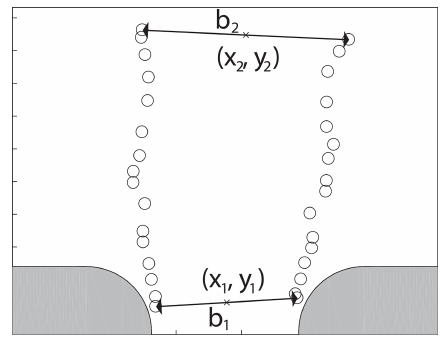
Figure 14. A sketch illustrating the dipole tracking. ( x 1 , y 1 ) repre- sents the position of the midpoint between the two vortices, and b 1 is the distance between the two vortices at separation time, t = T s . Likewise, ( x 2 , y 2 ) represents the position on the midpoint between the vortices, and b 2 is the distance between the vortices at t = T s + (cid:49)t